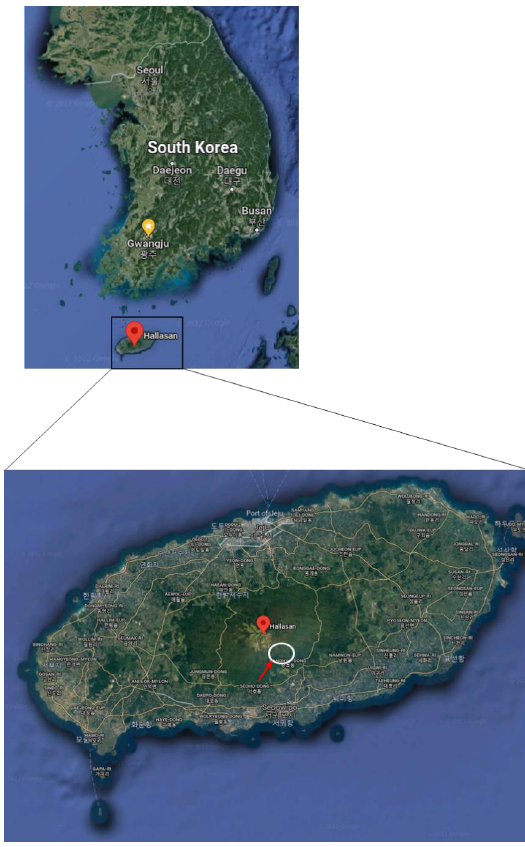
Figure 7. The sampling location of the Korean fir trees on Mt. Halla at an altitude of approximately 1700 – 1800 m above sea level. The trees were divided into two groups: control healthy trees (showing normal veg- etative growth and green needles) and standing die-back-affected dead trees (Figure 8).